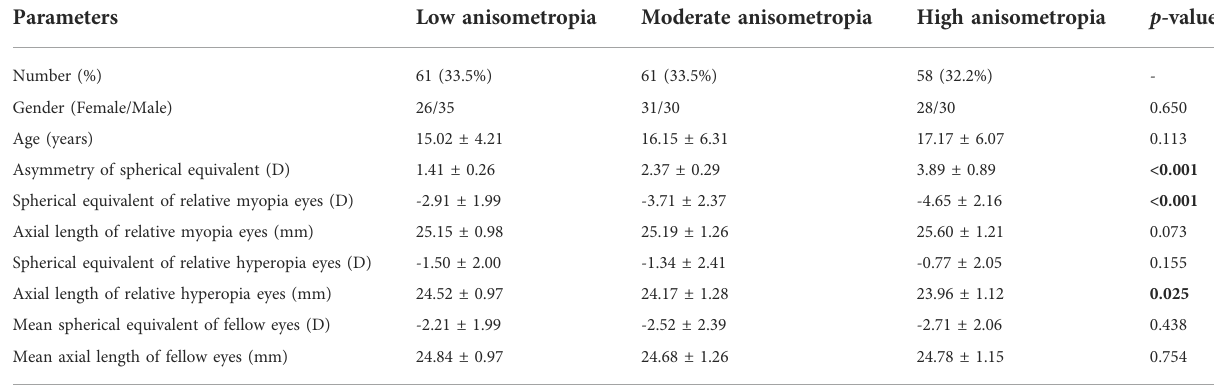
TABLE 5 Participant demographics among three